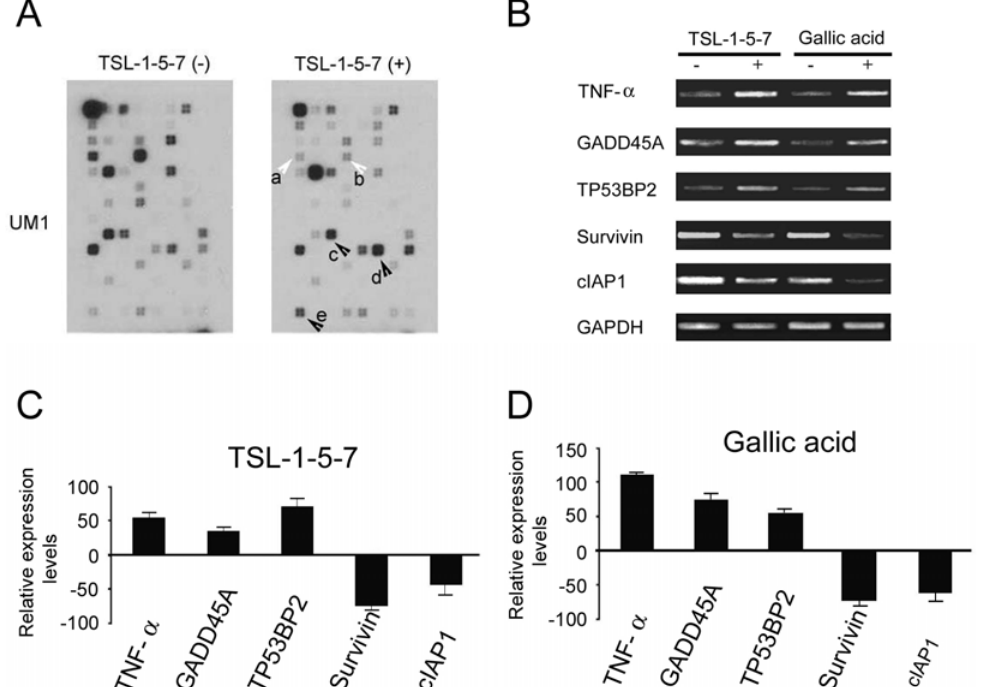
Figure 5. Microarray and semi-quantitative RT-PCR analysis of TNF- α , GADD45A, TP53BP2, Survivin, and cIAP expression in TSL-1-5-7- or gallic acid-treated or -untreated UM1